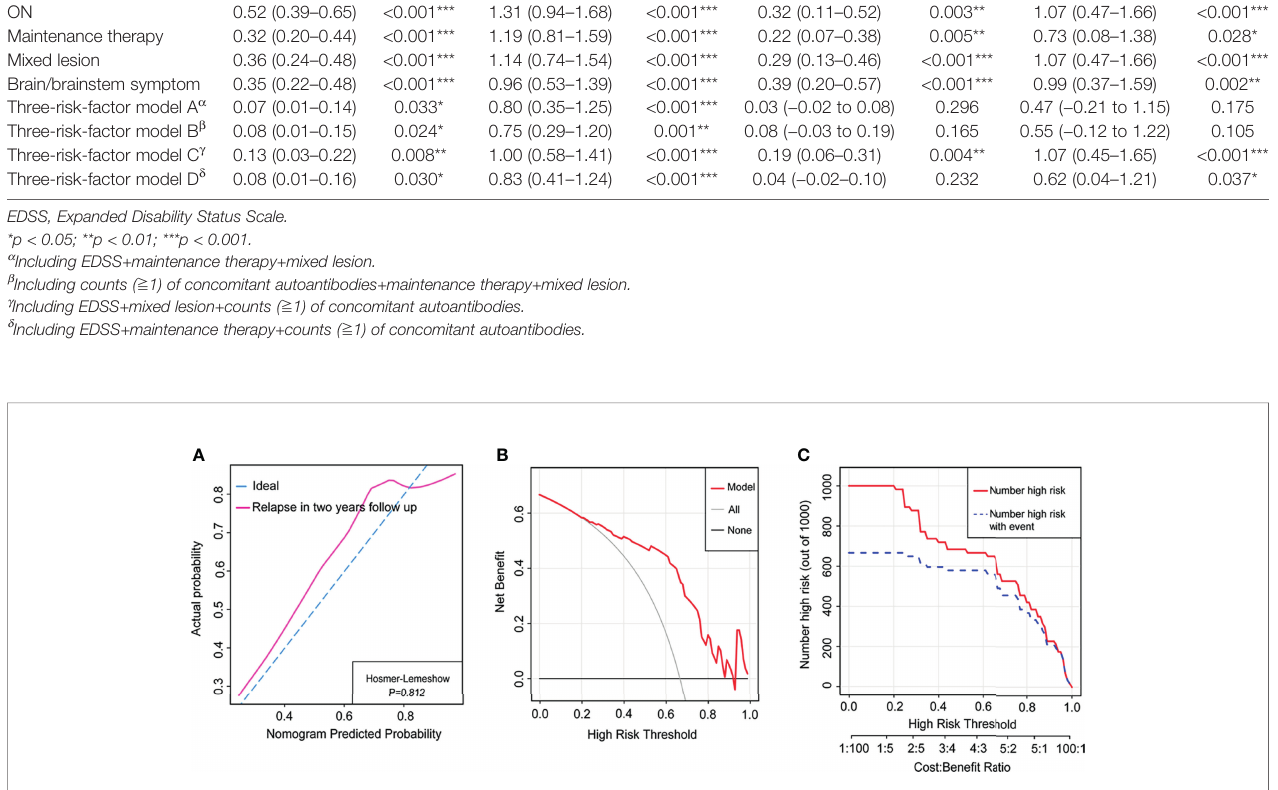
FIGURE 4 | The nomogram model predicted relapse in the whole cohort with 2-year follow-up. (A) The calibration curve indicated the probability of relapse in the cohort with 2-year follow-up. (B) Decision curve analysis of relapse in the cohort with 2-year follow-up. (C) Clinical impact curve of relapse in the cohort with 2-year